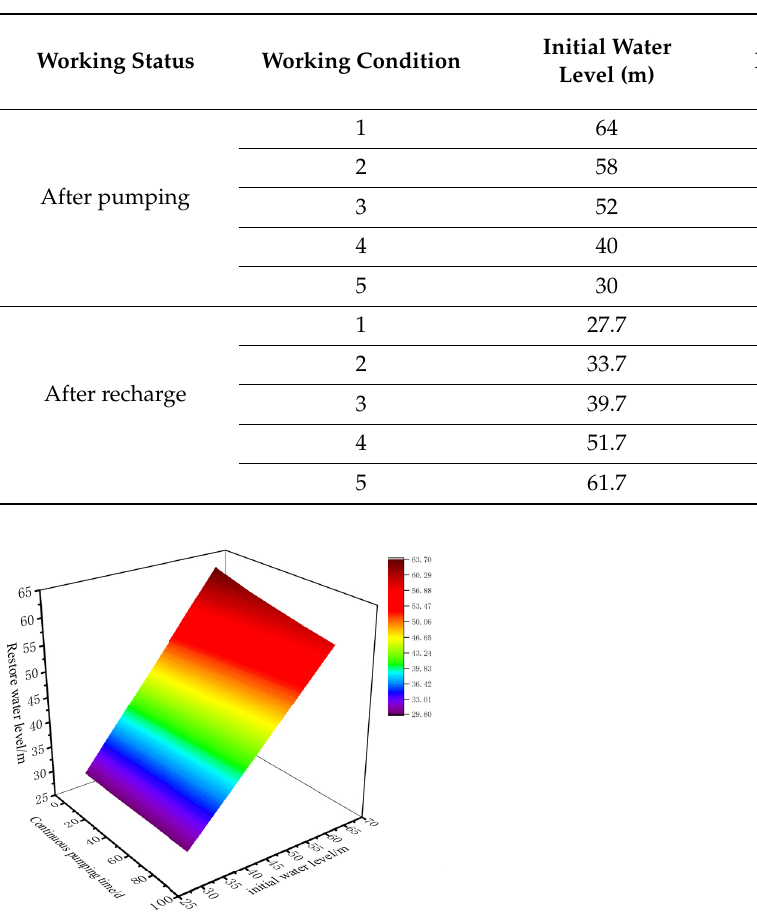
Table 4. Water level recovery condition after pumping and recharge.